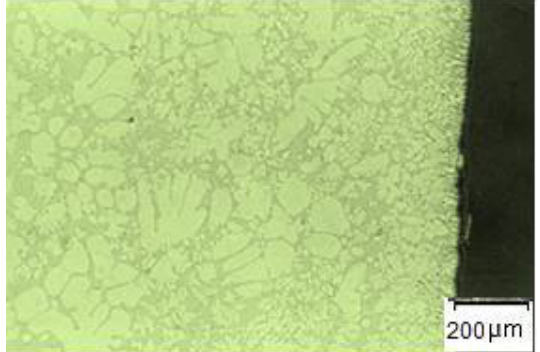
Figure 18. Microstructure of the edge part of the casting.